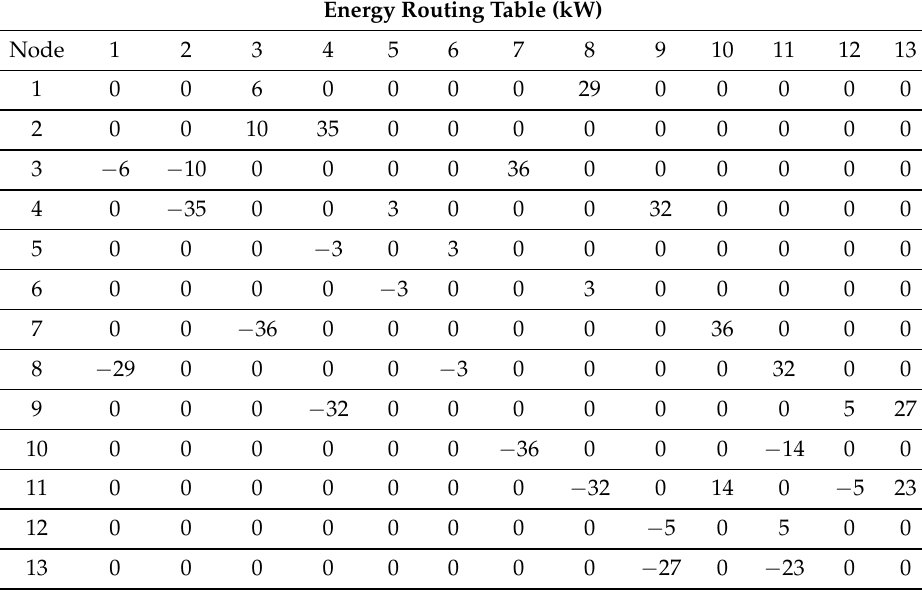
Table 2. Power assigned to the links of the NSFNET network by GRASP. Energy Routing Table